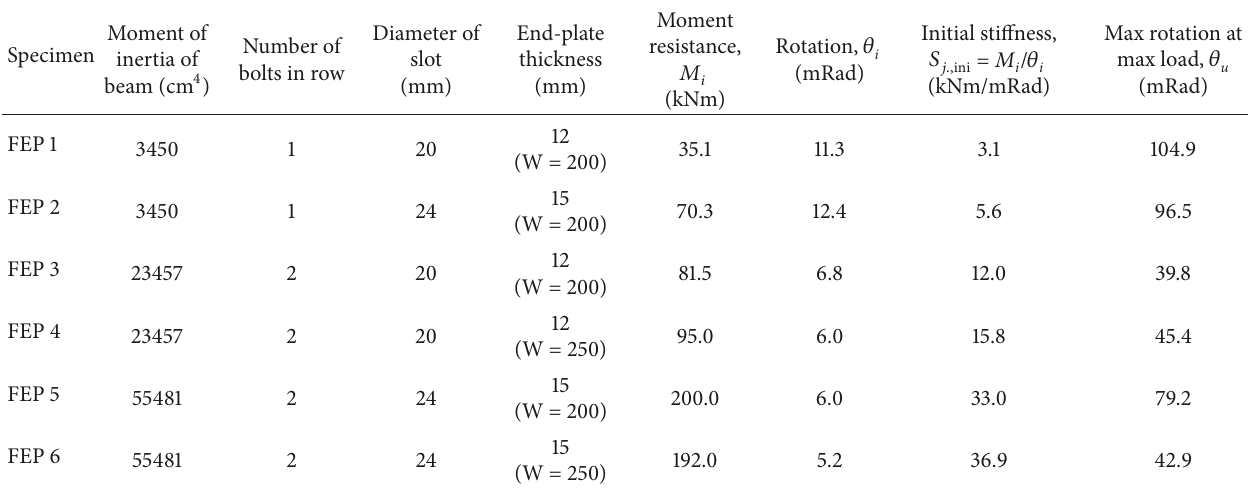
Table 3: Results of all the six beam-to-column connections.